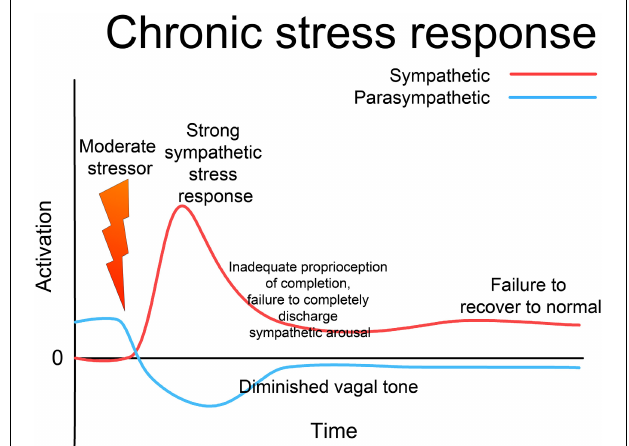
FIGURE 3 | Acute (mild) stress response. In response to a mild stressor the ANS (and the whole CRN) responds with sympathetic activation, accompanied by a reciprocal lessening of vagal (parasympathetic) tone. Usually this activation will support an appropriate response to the stressor; this response will be accompanied by proprioceptive feedback that the response has been successfully completed. Sympathetic activation then diminishes, vagal tone returns to normal, and the whole CRN resets to normal resilient functioning.